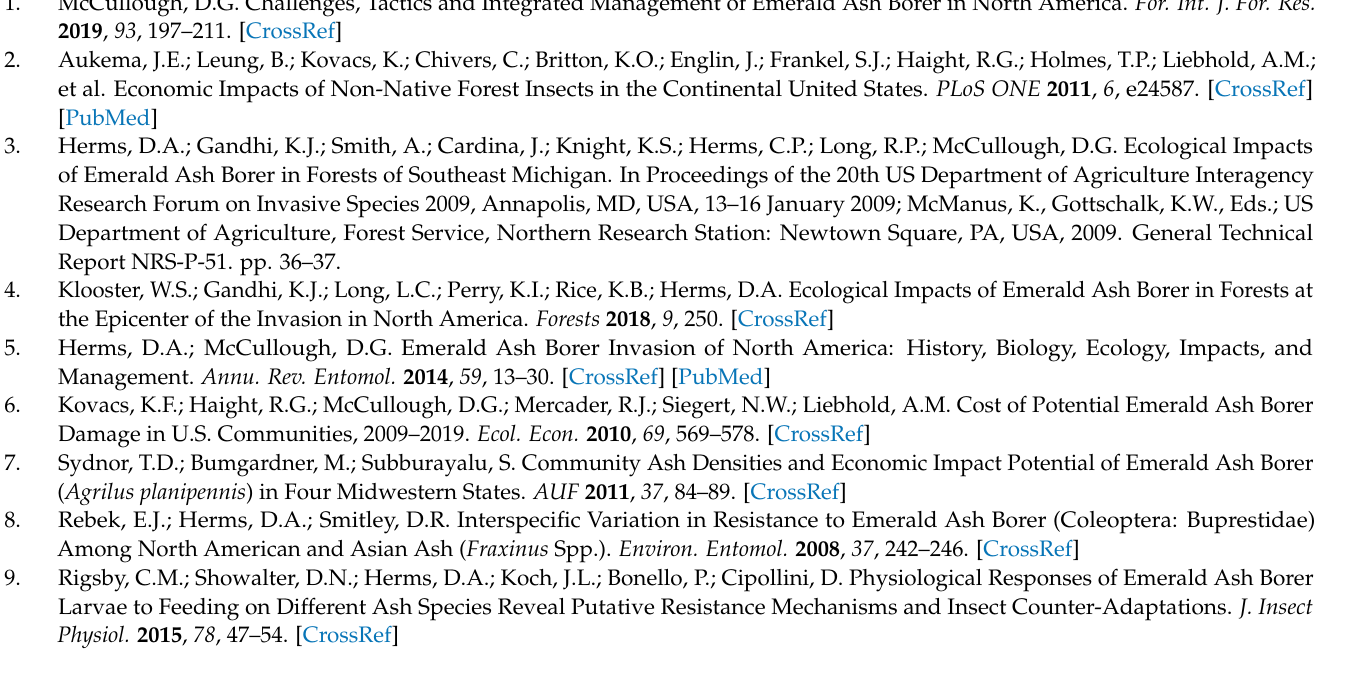
microcosm boxplot; Figure S2: Block vs. sapwood disc substrate, agar microcosm boxplot; Figure S3: Soil vs. agar microcosm, block substrate boxplot; Figure S4: Soil vs. agar microcosm, disc substrate